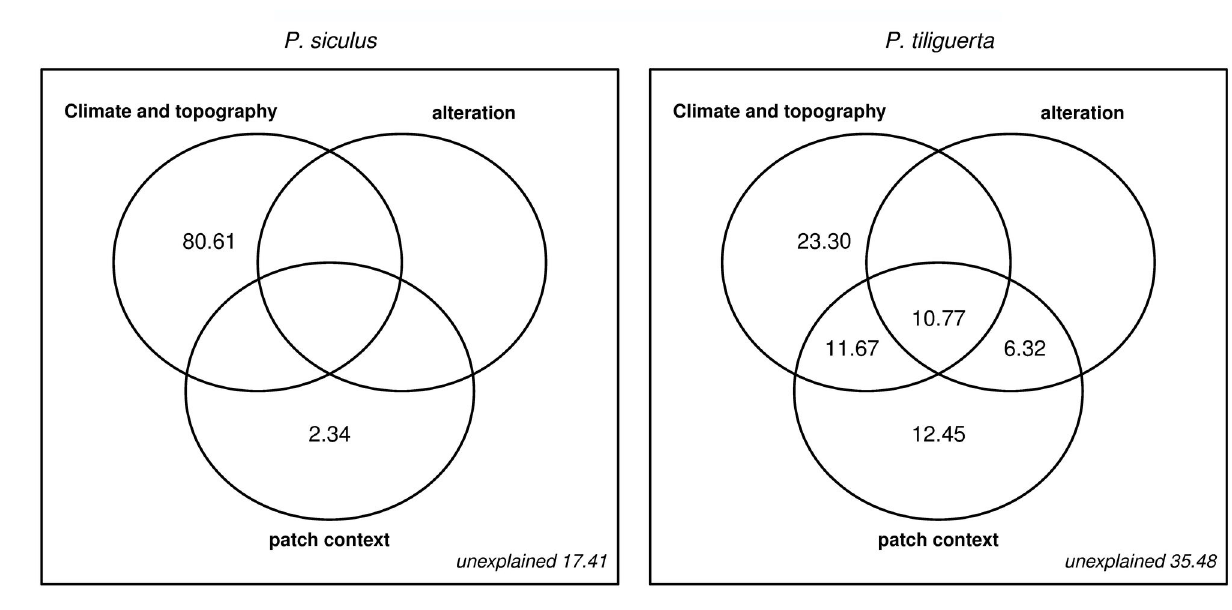
Figure 3. Variation partitioning diagrams for the H hypothesis for the two species. Circles represent variation explained by 2 each factor (climate and topography, alteration, patch context). Numbers correspond to the percentage of variation associated to each circle subpart (pure, two-factor intersection, three factors intersection). The percentage associated to intersecting areas has not to be interpreted as interaction, but as a variation indifferently assignable to one or more factors [65]. Values smaller than 0.01% are not